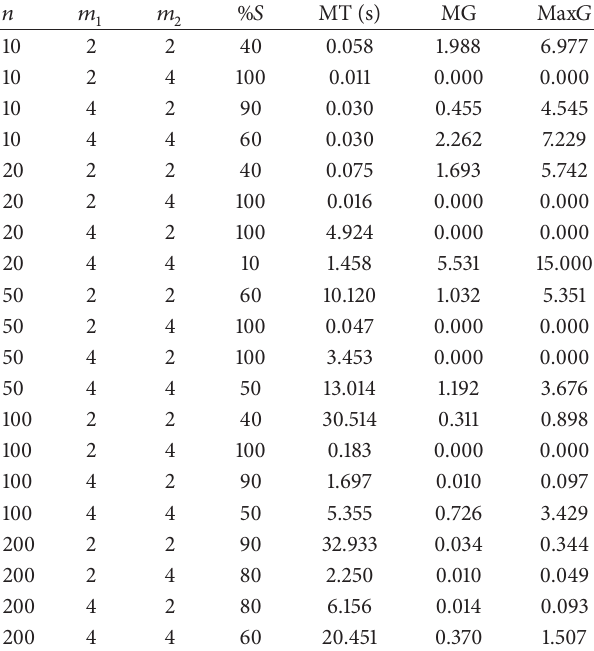
Table 1: Performance for 𝑎 = 𝑏 = 𝑐 = 𝑑 = 20 .